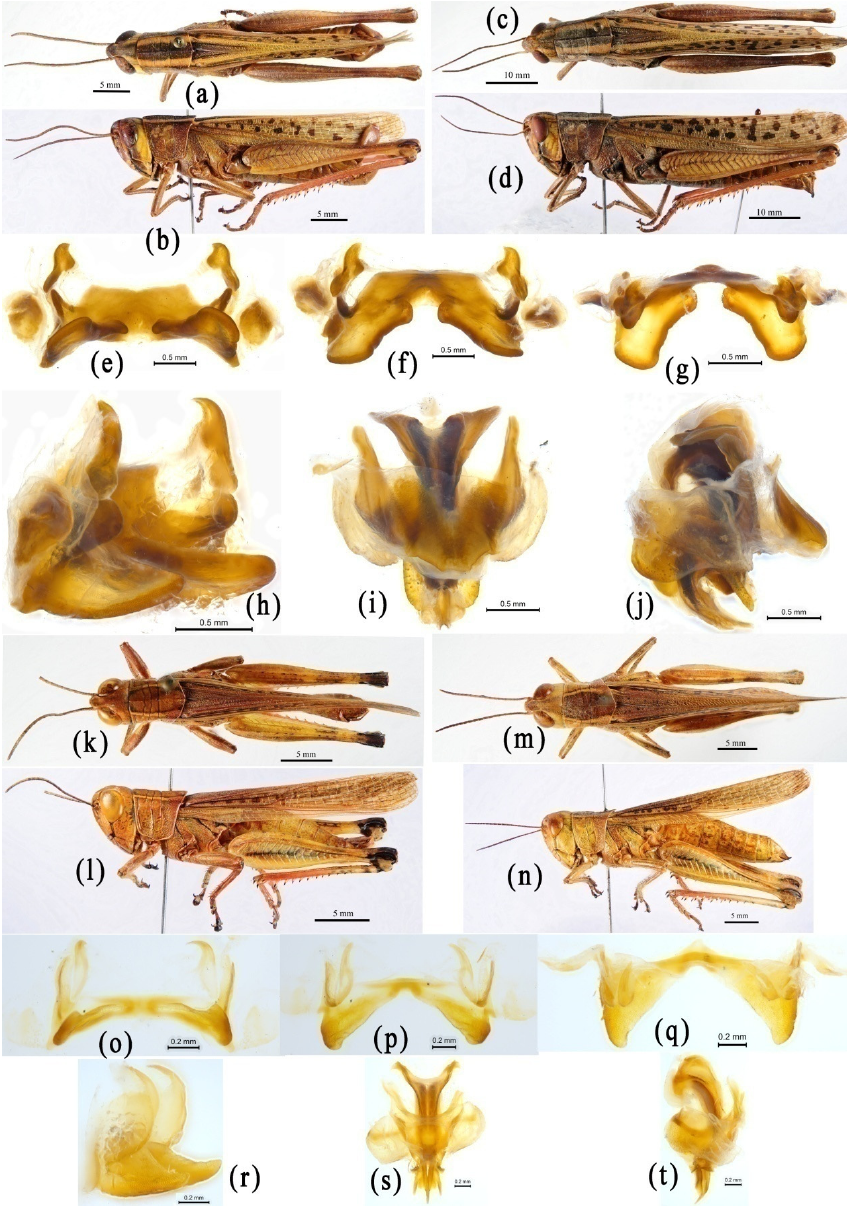
Figure 5. Morphological characters of Choroedocus capensis and Shirakiacris shirakii . ( a – j ) Choroedocus capensis . ( a , b ) Male habitus. ( c , d ) Female habitus. ( e – h ) Epiphallus in dorsal, dorsofrontal, frontal and dorsolateral views. ( i , j ) Phallic complex in dorsal and lateral views. ( k – t ) Shirakiacris shirakii . ( k , l ) Male habitus. ( m , n ) Female habitus. ( o – r ) Epiphallus in dorsal, dorsofrontal, frontal and dorsolateral views. ( s , t ) Phallic complex in dorsal and lateral views.